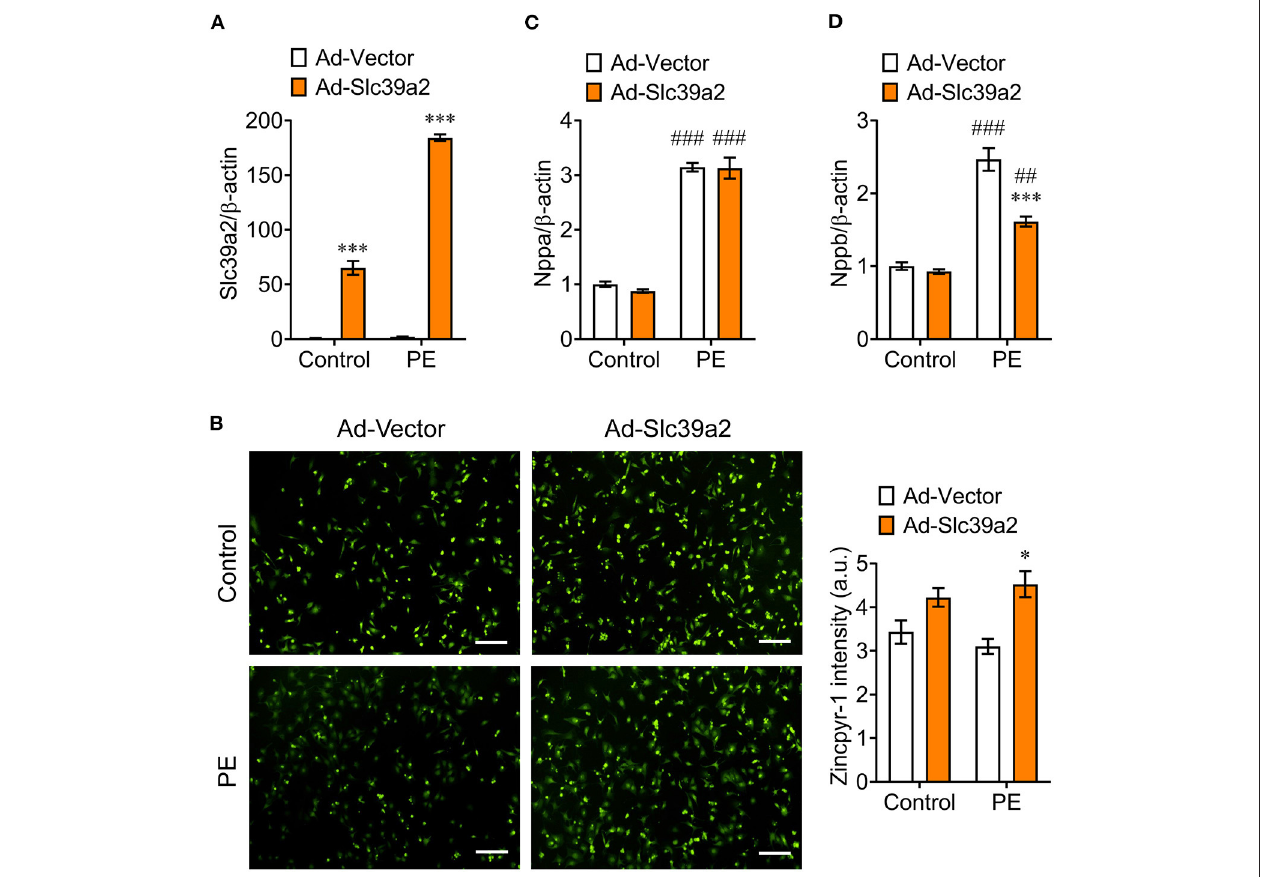
FIGURE 3 | Slc39a2 overexpression increases zinc uptake and alleviates PE-induced cardiomyocyte hypertrophy. (A) Overexpression of Slc39a2 by adenovirus (Ad-Slc39a2). *** P < 0.001 vs. Ad-Vector. n = 3. (B) Representative images (left) and quantification data (right) showing the impact of Slc39a2 overexpression on Zinpry-1 staining in NRVMs with or without PE treatment. * P < 0.05 vs. Ad-Vector. n = 3. (C,D) Impact of Slc39a2 overexpression on PE-induced expressions of Nppa (C) and Nppb (D) . *** P < 0.001 vs. Ad-Vector; ## P < 0.01, ### P < 0.001 vs. Control. n =